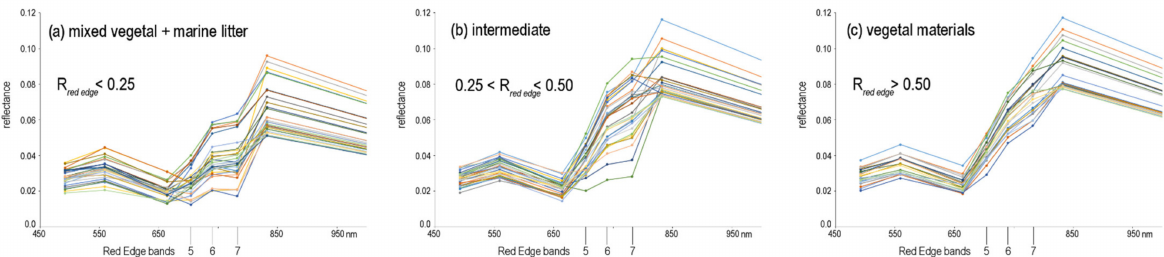
Figure 5. Spectra of ‘mixed’ ( a ), ‘intermediate’ ( b ) and ‘vegetal’ ( c ) classified matter detected in North Adriatic in August 2020 (top-20 pixels in band 8 for each